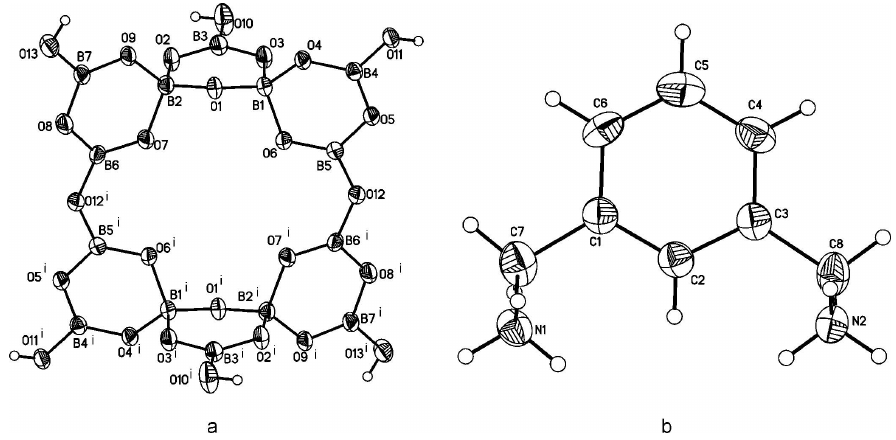
Figure 1 The crystal structure of [(C level. [Symmetry codes: (i) - x +1, - y +1, - z +1.]